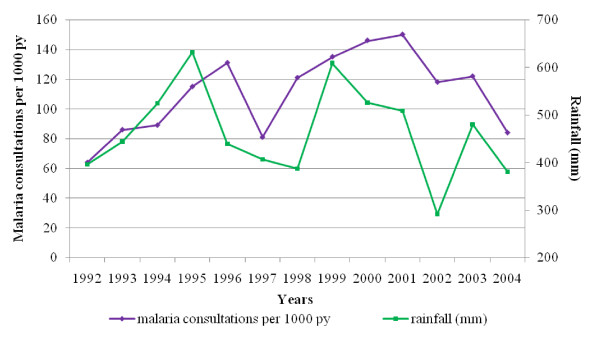
Malaria consultations and annual rainfall in Niakhar area, 1992-2004. The purple line represents the clinical malaria morbidity in dispensaries per 1,000 person-year at risk (py). The green line represents the annual rainfall (mm) in Niakhar village.